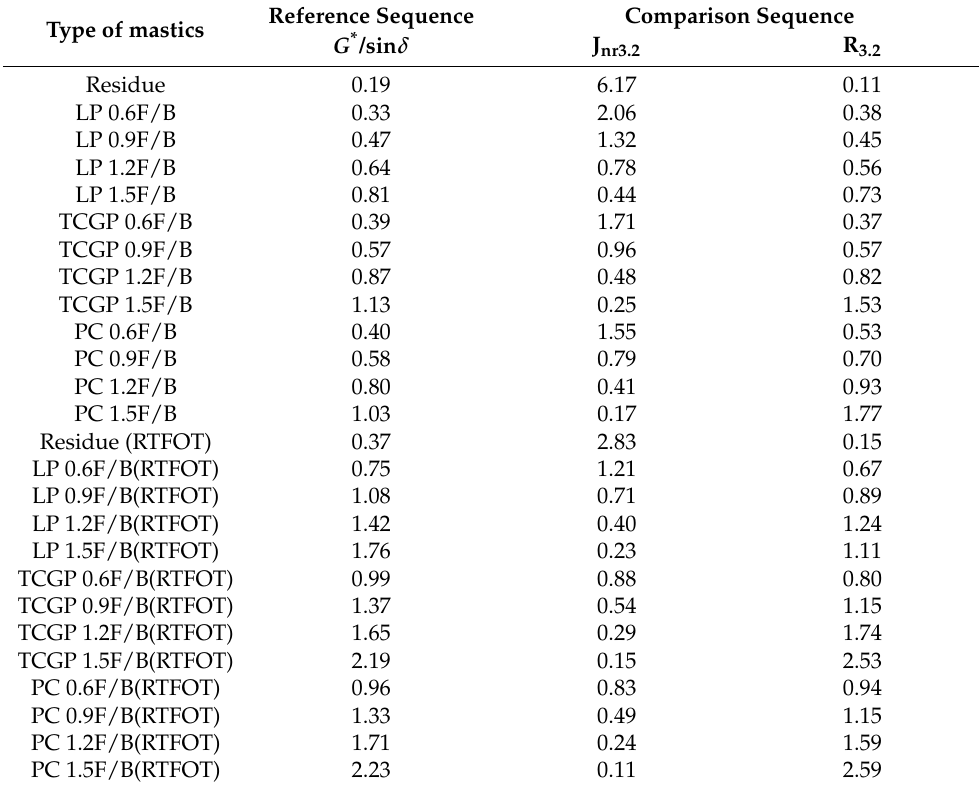
Table 8. The rheological property index of emulsified asphalt mastics after dimensionless treatment. Type of mastics